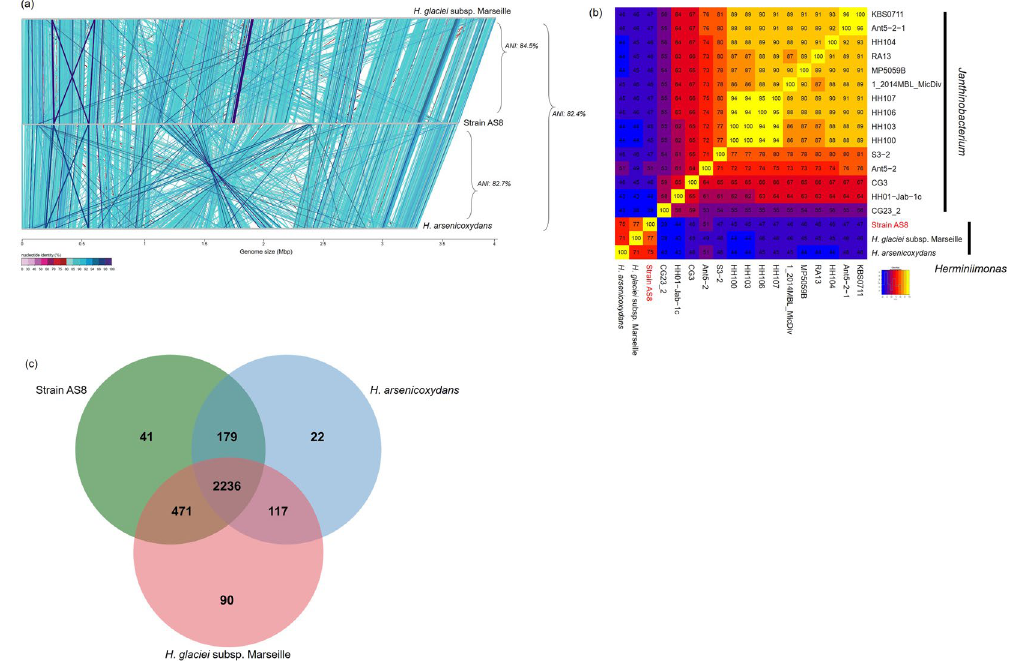
Figure 4. A comparative genome analysis of AS8, H . arsenicoxydans , and H . glaciei subsp. Marseille. ( a ) A whole-genome alignment of the three strains. The genomes have been linearized for simplicity and are arranged in the same order. The synteny of nucleotide sequences is indicated by vertical lines. ( b ) The matrix of percentages of conserved sequences calculated from the genomes for strain AS8, Herminiimonas spp., and Janthinobacterium spp. ( c ) Venn diagrams showing the numbers of CDSs shared between the predicted proteins of strain AS8 (green), H . arsenicoxydans (sky-blue), and H . glaciei subsp. Marseille (Red). The whole-genome orthologous gene comparisons were performed based on the OrthoVenn default value of OrthoVenn (http:// probes.pw.usda.gov/OrthoVenn/start.php). The numbers indicate the total number of